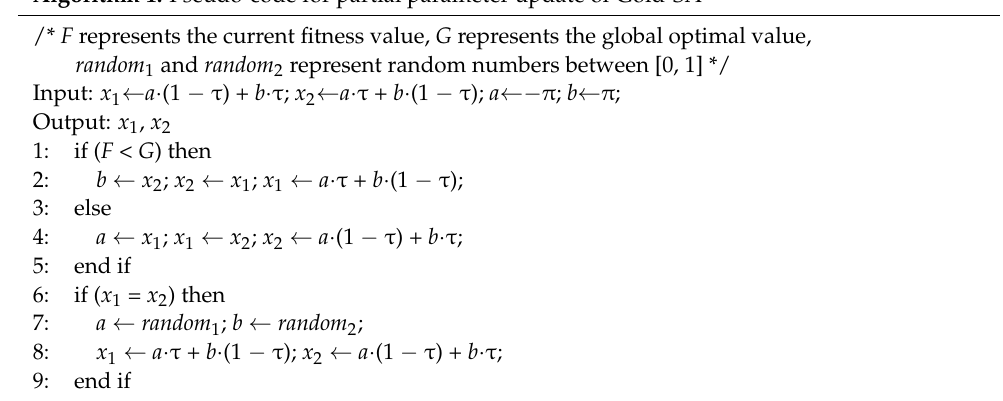
Algorithm 1: Pseudo-code for partial parameter update of Gold-SA /* F represents the current fitness value, G represents the global optimal value, random 1 and random 2 represent random numbers between [0, 1]